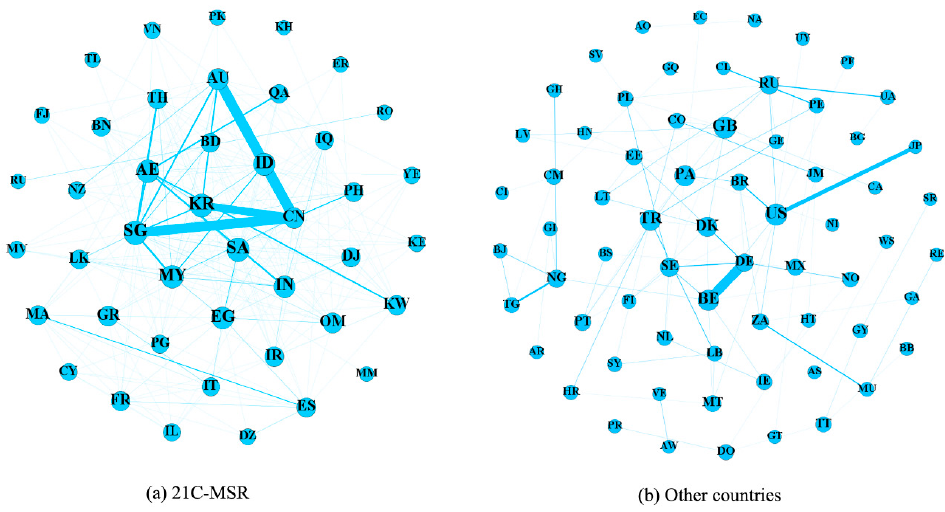
Sensors 2019 , 19 , x FOR PEER REVIEW Figure 10. Maritime network structure variations; (a) 21C-MSR and (b) other countries. Figure 10. Maritime network structure variations; ( a ) 21C-MSR and ( b ) other countries.